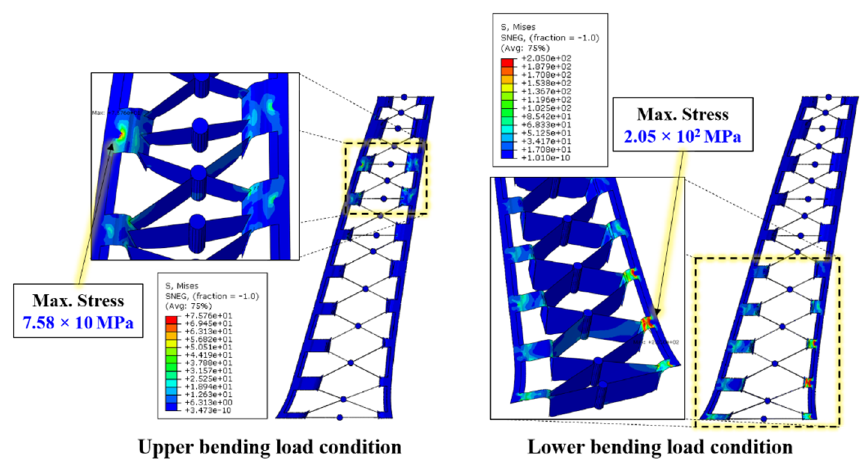
Figure 19. Details of von Mises contour results for GFRP rib part.